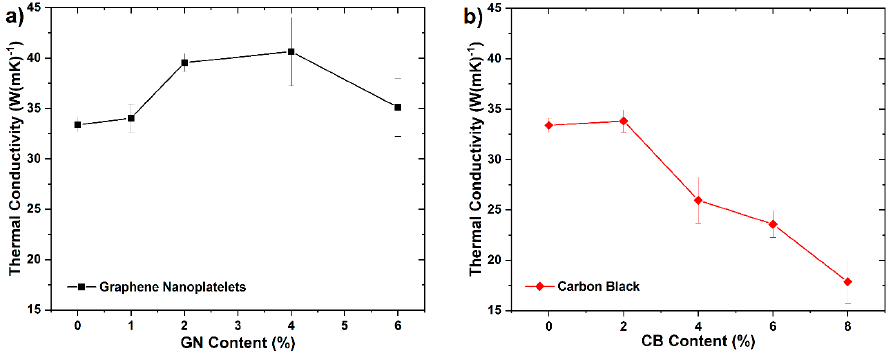
Figure 5. Thermal conductivity of composites depending on the content of secondary nanofillers: ( a ) graphene nanoplatelets, ( b ) carbon black.